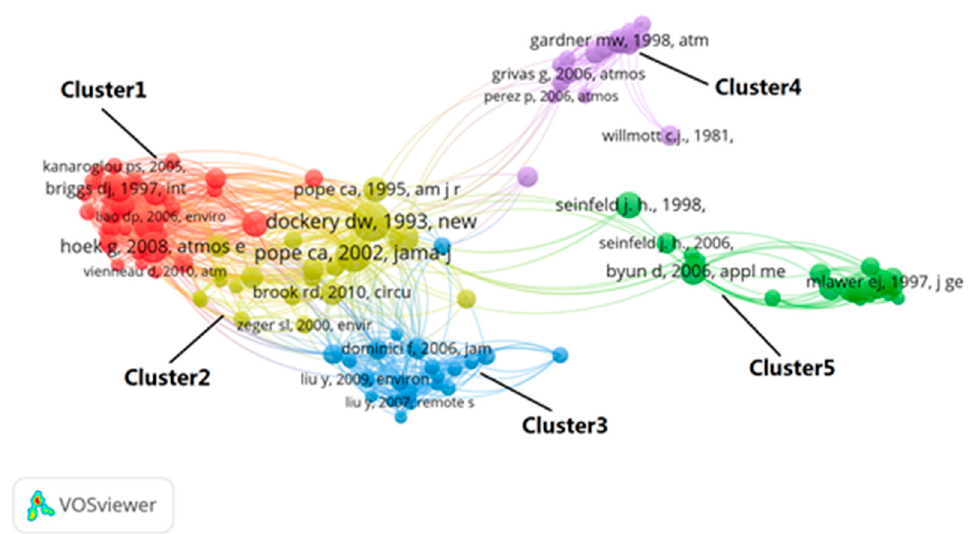
Figure A2. A co-citation map of the selected studies involving air pollutant prediction from 1990 to 2018 (note: each node represents a document, the node size represents the number of citations, and the connection between nodes represents the co-citation relationship). Table A3. Classification rules of the evolutionary tree.